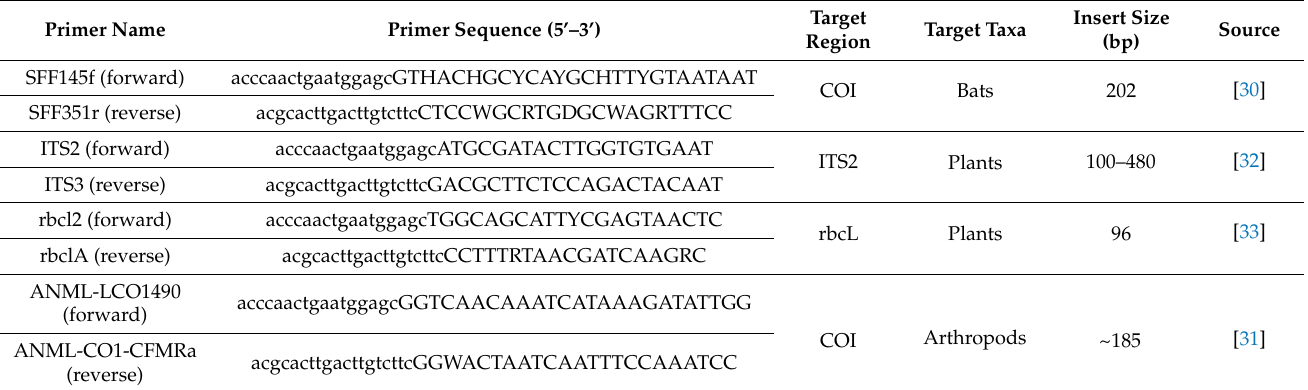
Table 1. Metabarcoding primers (uppercase) used in multiplex PCR for detection of L. nivalis (or other vertebrates), plants, and arthropods from agave flower cuttings or swabs. Lowercase nucleotides are 5 (cid:48) -modified universal tails [34] that allowed for Illumina library preparation in a second PCR